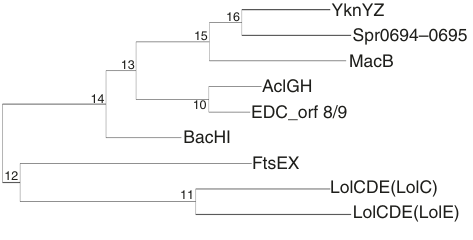
Fig. 7 Molecular phylogenetic analysis of Spr0694 – 0695 homologs by Maximum Likelihood method. The sequences of Spr0694 – 0695 and homologs are from the following organisms (the UniProt code of these proteins is given): Streptococcus pneumoniae (Spr0694, Q8DQF8; Spr0695, Q8DQF7; FtsE, A0A064BZ20; FtsX, Q04LE4), Bacillus subtilis (strain 168) (YknY, O31711; YknZ, O31712), Escherichia coli (strain K12) (MacB, P75831; LolC, P0ADC3; LolE, P75958), Staphylococcus aureus (AclG, X4XWR7; AclH, X4Y386), Staphylococcus epidermidis (EDC_orf8, H9BG71; EDC_orf9, H9BG72), Enterococcus faecalis (BacH, O52970; BacI,